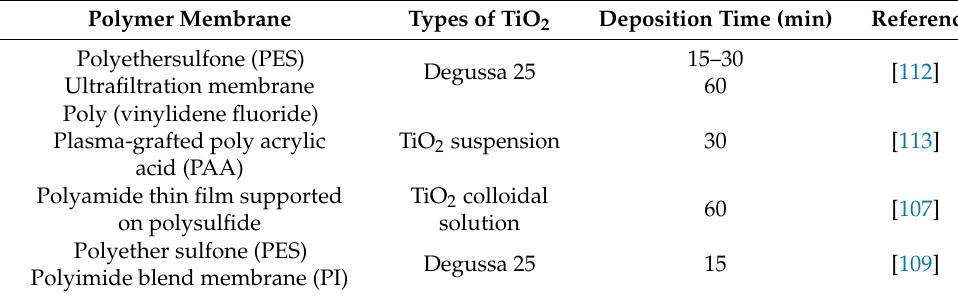
Table 4. Polymer membranes with different TiO 2 types.